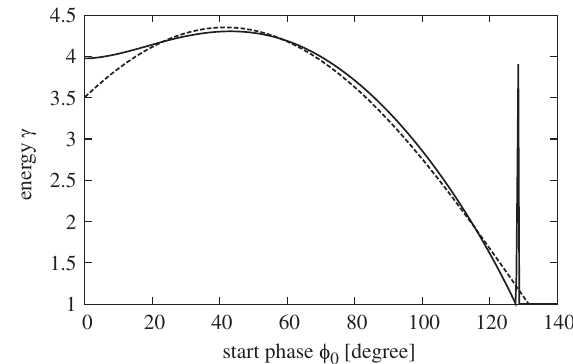
FIG. 2. Synchronous phase versus start phase for α ¼ 1 . 8 . The solid line shows the exact, numerical solution. The broken line corresponds to Eq. (20), and the dotted line follows Eq. (14). Both analytical approximations deviate from the exact solution at high phases [Eq. (20) has no solution for ϕ 0 > 136 °], because the condition ~ γ ≫ 1 is not fulfilled.